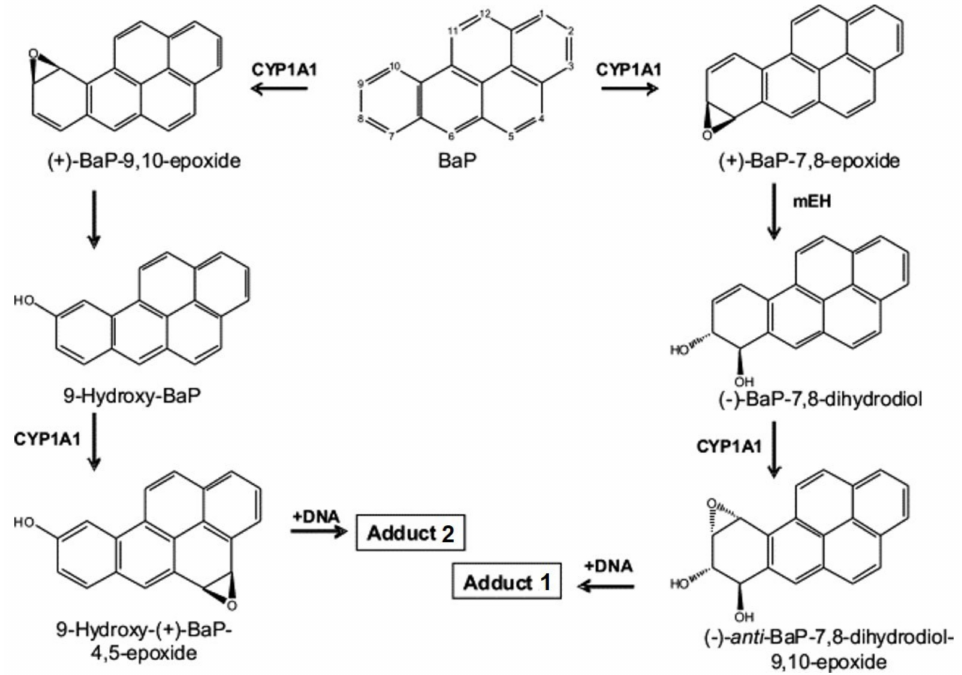
Figure 1. Scheme of BaP biotransformation pathways and DNA adduct formation catalysed by CYP1A1 and mEH (taken and edited from